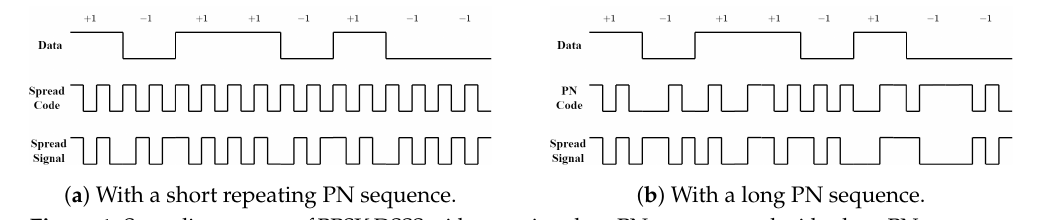
Figure 1. Spreadingprocess of BPSKDSSS with repeating shortPN sequence and with along PN